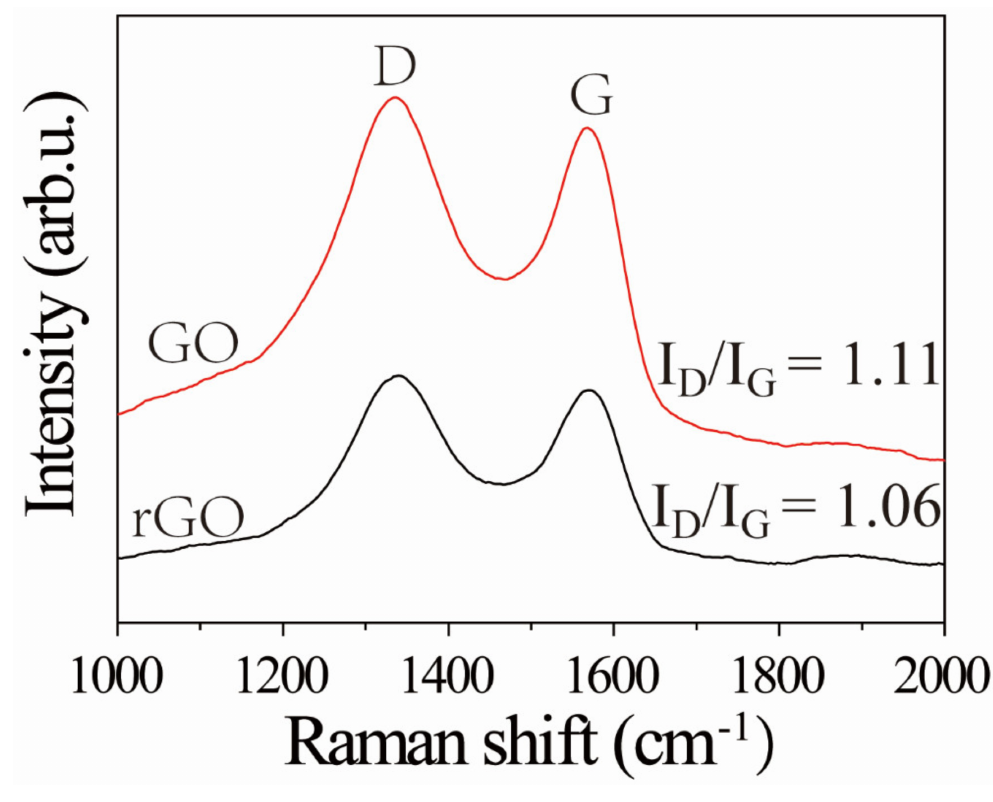
Figure 3. Raman spectra of GO and rGO